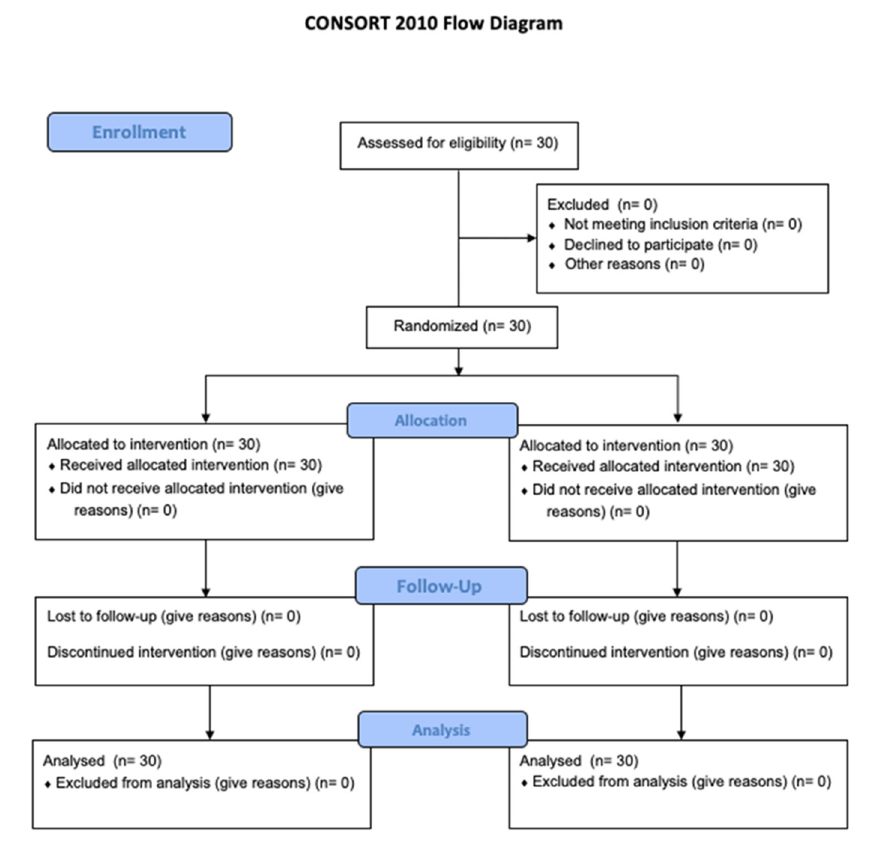
Figure 1. CONSORT diagram of the patient’s allocation by randomization.